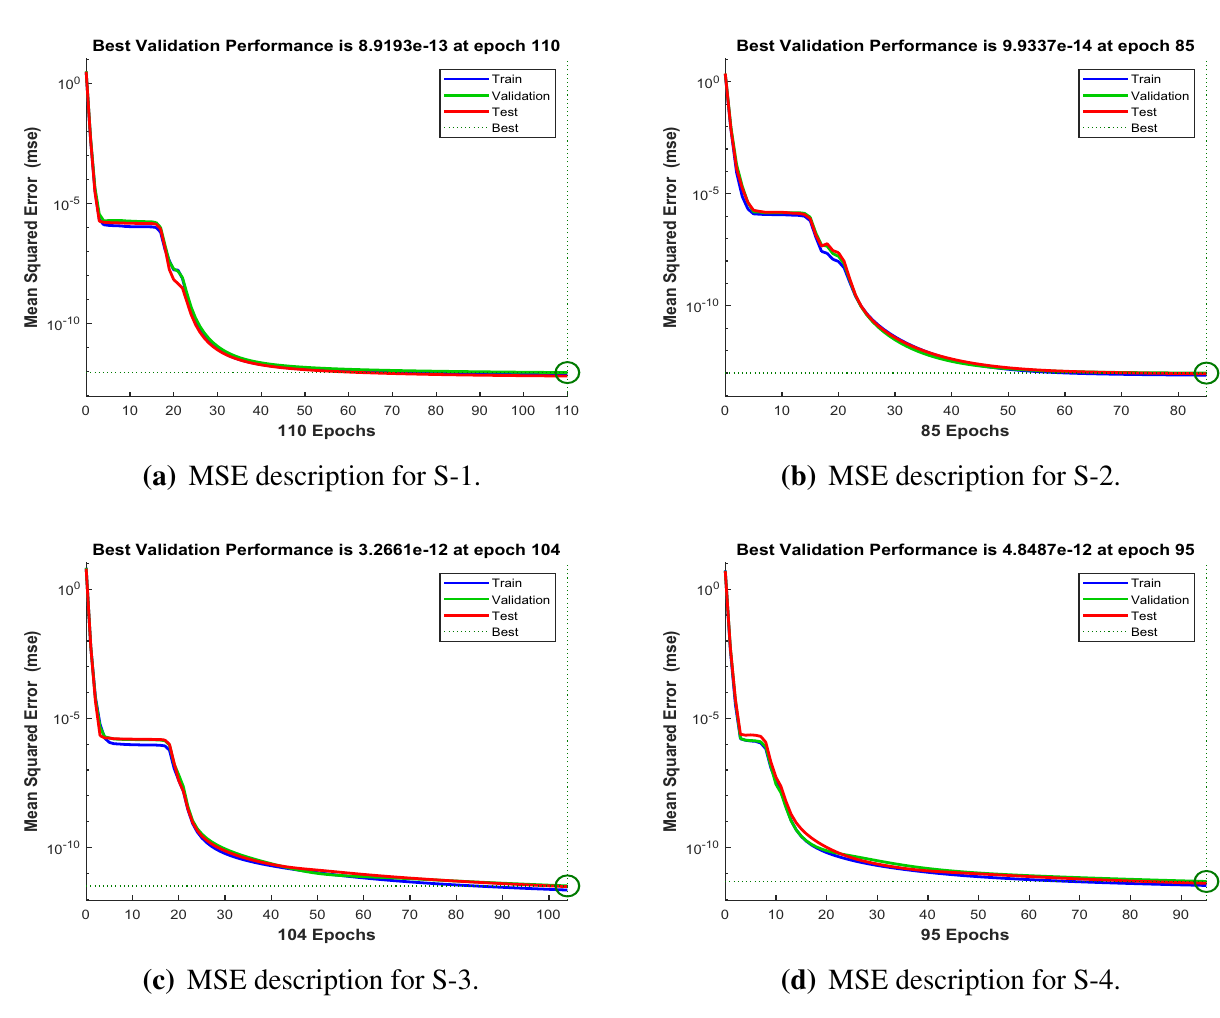
Figure 6. Performance of the LMA-TNN for testing, validation, and training procedures of Case 2 in constant